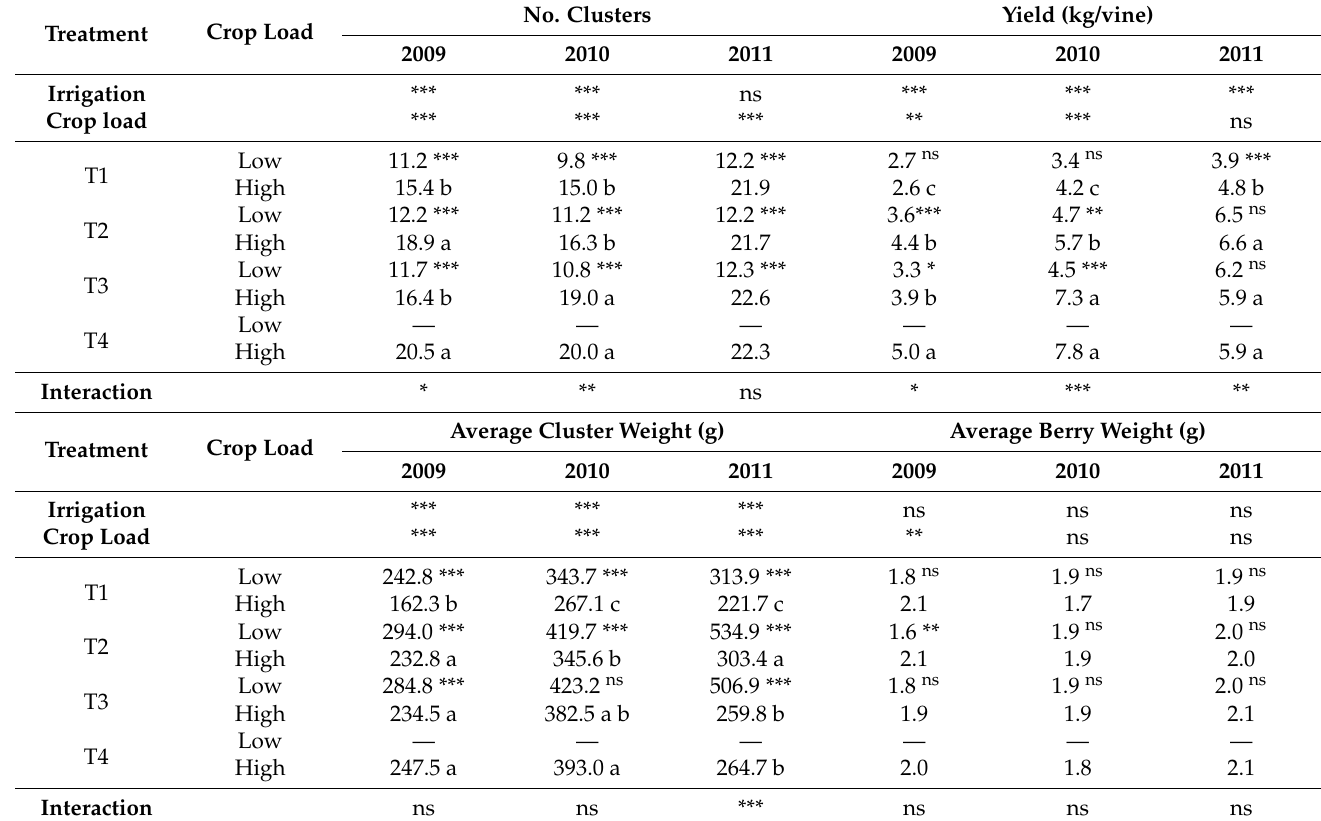
Table 5. Yield and yield components in the different irrigation and load treatments, in the years 2009, 2010, and 2011.